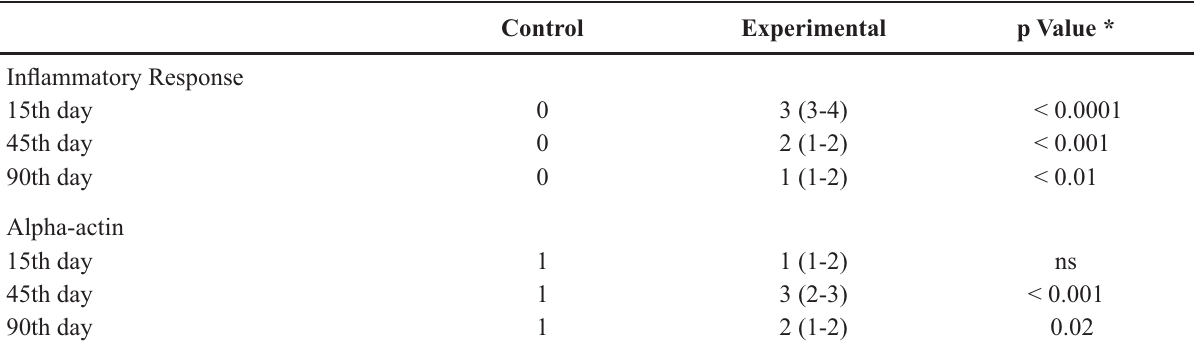
Table 1 – (cid:3)(cid:44)(cid:81)(cid:192)(cid:68)(cid:80)(cid:80)(cid:68)(cid:87)(cid:82)(cid:85)(cid:92)(cid:3)(cid:85)(cid:72)(cid:86)(cid:83)(cid:82)(cid:81)(cid:86)(cid:72)(cid:3)(cid:68)(cid:81)(cid:71)(cid:3)(cid:68)(cid:79)(cid:83)(cid:75)(cid:68)(cid:16)(cid:68)(cid:70)(cid:87)(cid:76)(cid:81)(cid:3)(cid:76)(cid:80)(cid:80)(cid:88)(cid:81)(cid:82)(cid:72)(cid:91)(cid:83)(cid:85)(cid:72)(cid:86)(cid:86)(cid:76)(cid:82)(cid:81)(cid:3)(cid:68)(cid:70)(cid:70)(cid:82)(cid:85)(cid:71)(cid:76)(cid:81)(cid:74)(cid:3)(cid:87)(cid:82)(cid:3)(cid:87)(cid:75)(cid:72)(cid:3)(cid:74)(cid:85)(cid:82)(cid:88)(cid:83)(cid:86)(cid:3)(cid:68)(cid:87)(cid:3)(cid:71)(cid:76)(cid:73)(cid:73)(cid:72)(cid:85)(cid:72)(cid:81)(cid:87)(cid:3)(cid:87)(cid:76)(cid:80)(cid:72)(cid:86)(cid:3)(cid:82)(cid:73)(cid:3)(cid:72)(cid:89)(cid:68)(cid:79)(cid:88) - ation. Data expressed as medians and